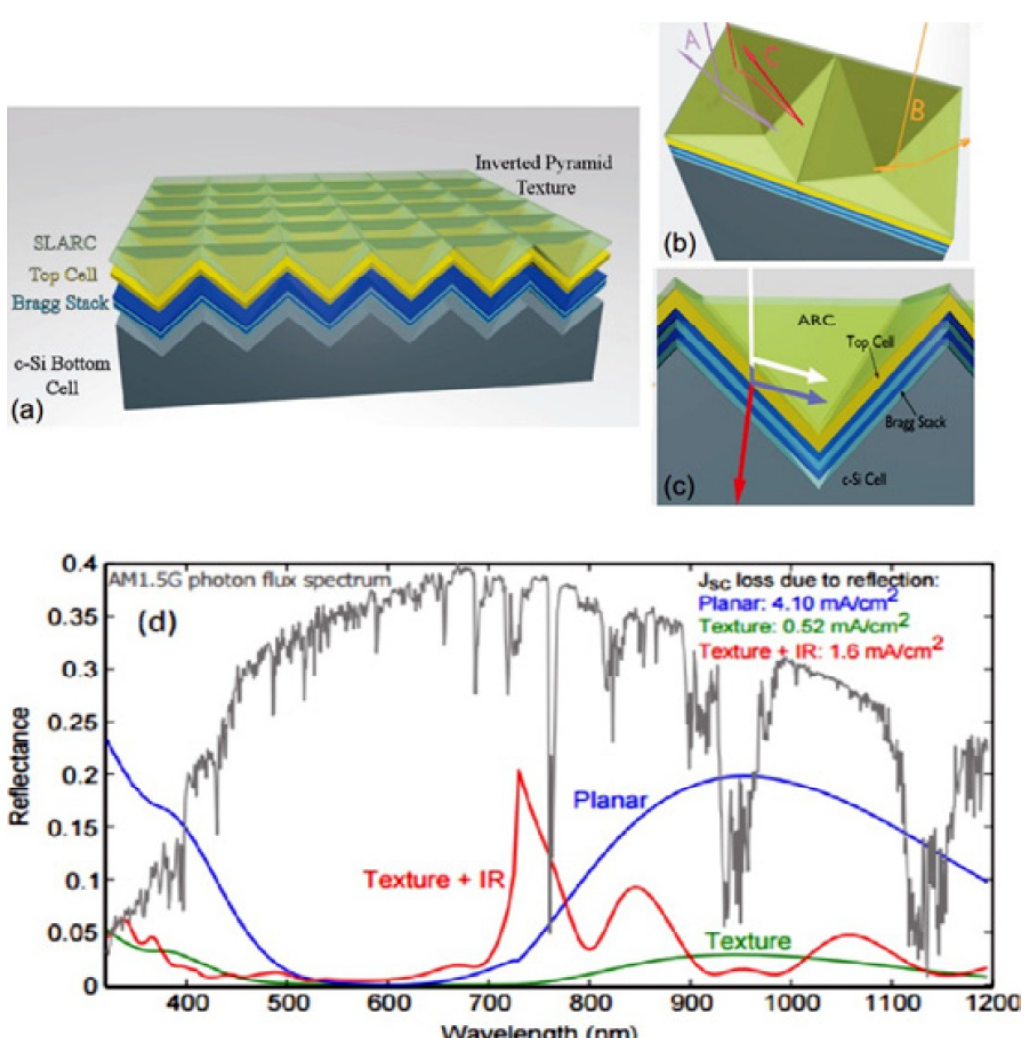
Fig. 8. (a) Textured surface wide-angle view which shows the cross-sectional conformal deposition of the layers. (b) Three possible inverted pyramid texture light paths for. (c) The schematic internal optical struc- ture cross-section of: the intermediate reflector transfers not high energy light into the bottom c-Si cell (red arrow), reflects short wavelength goes into the top cell (indigo arrow). (d) Front-surface reflectance and equivalent reflected J for each structure. A normalized AM1.5G solar band is illustrated in gray colour for sc reference. Reprinted with permission from B. W. Schneider, N. N. Lal, S. Baker-Finch and T. P. White